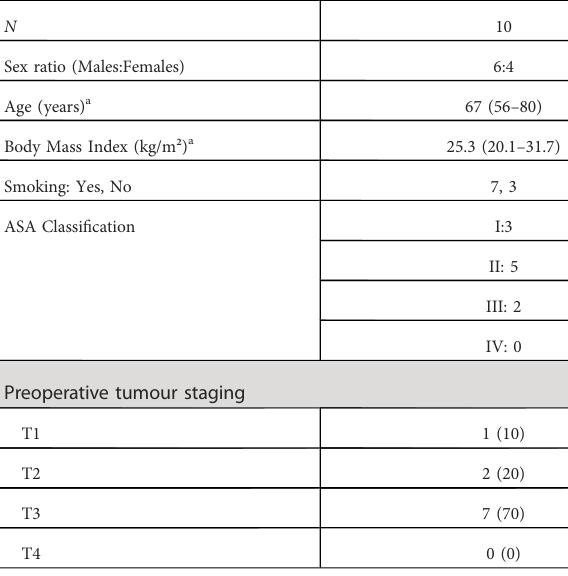
TABLE 1 Patient